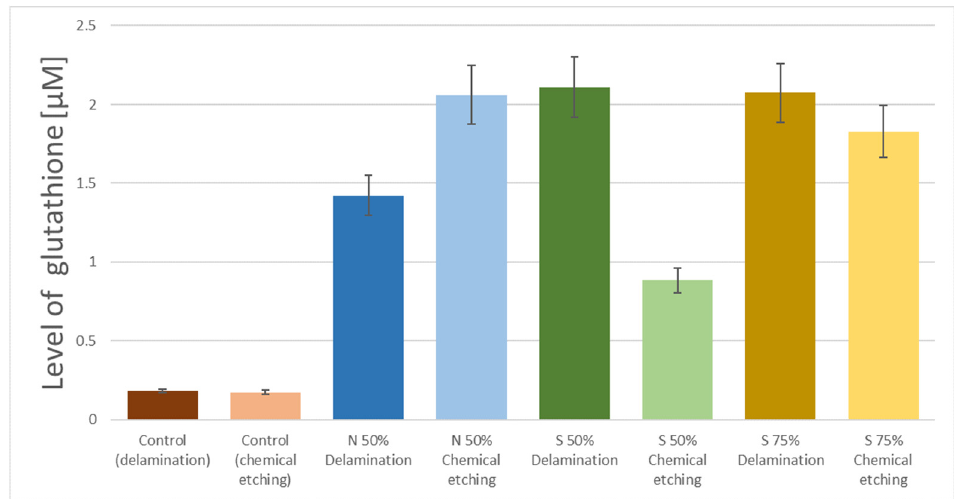
Figure 8. A comparison of activation with inorganic acids for both types of graphene (N50%—50% nitric acid, S50%—50% sulfuric acid, S75%—75% sulfuric acid).